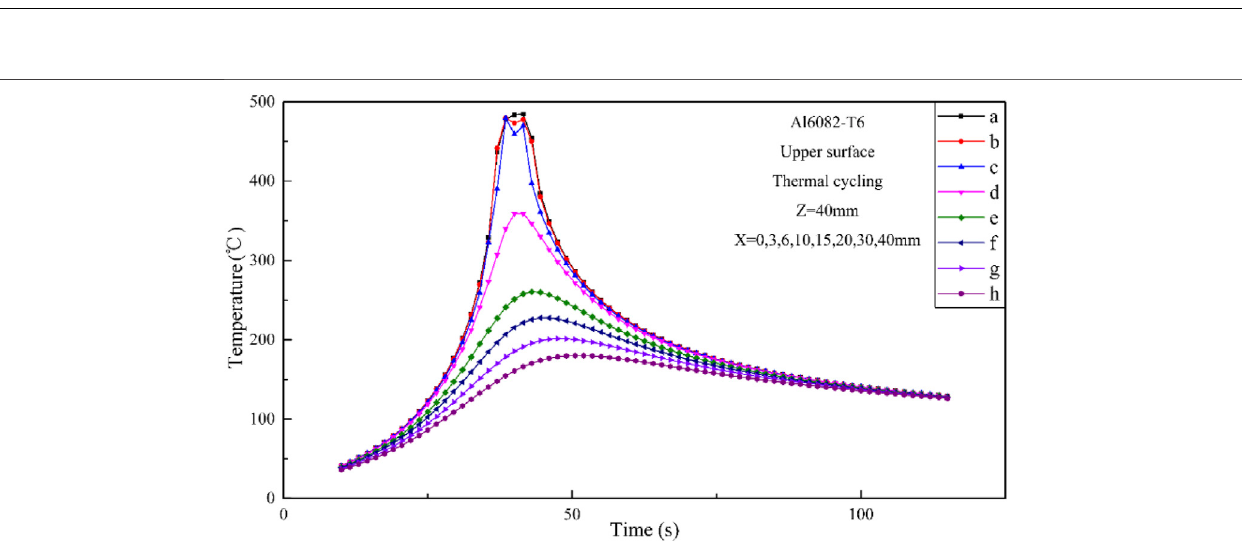
FIGURE 8 | Thermal cycle curves of feature points on the upper surface of the workpiece.